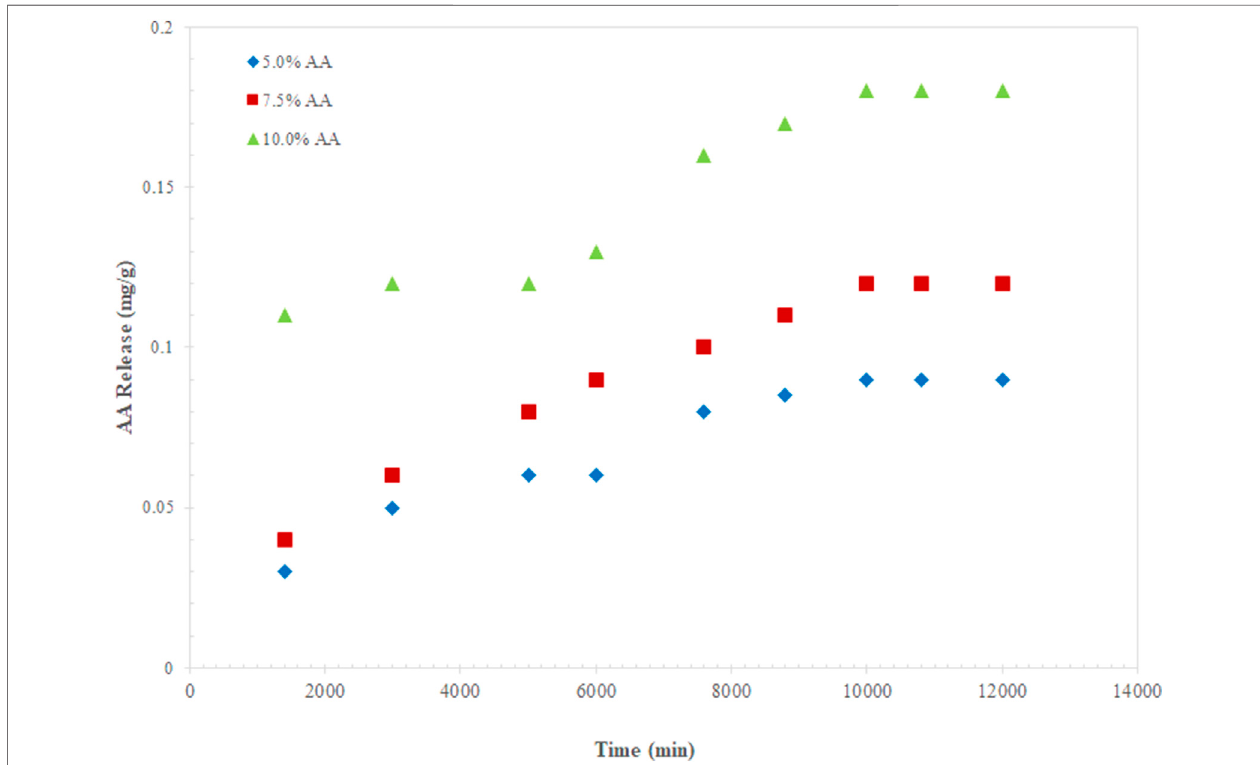
FIGURE 5 | Release kinetics of AA from chitosan fi